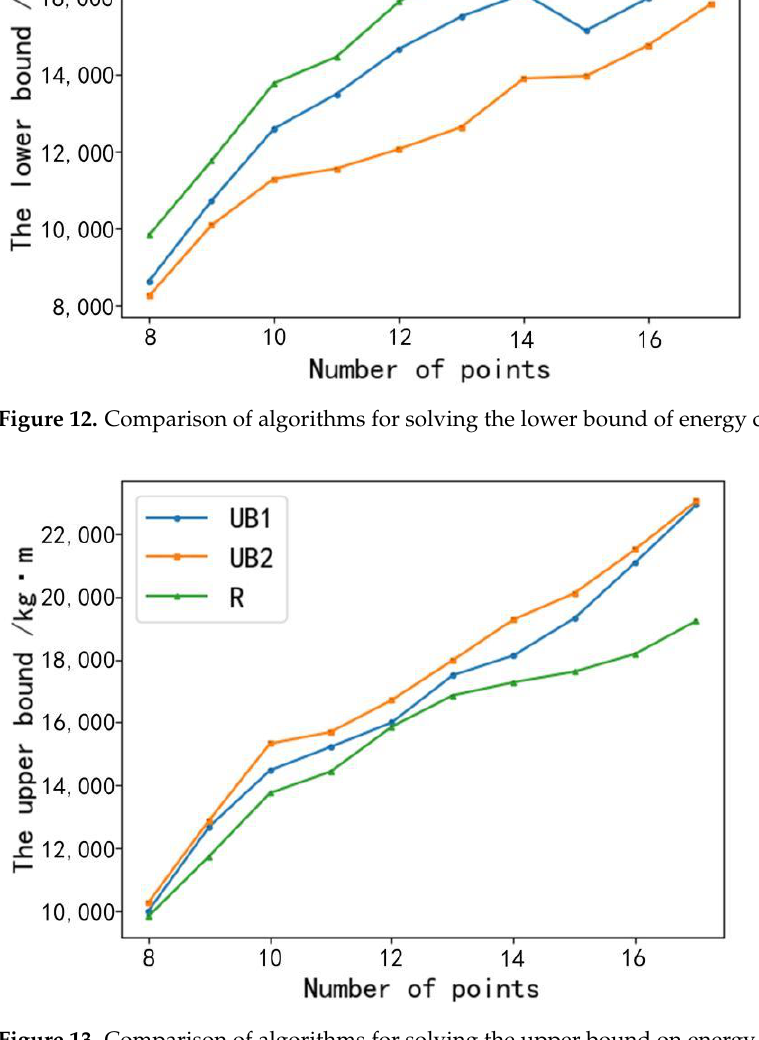
Figure 13. Comparison of algorithms for solving the upper bound on energy consumption.